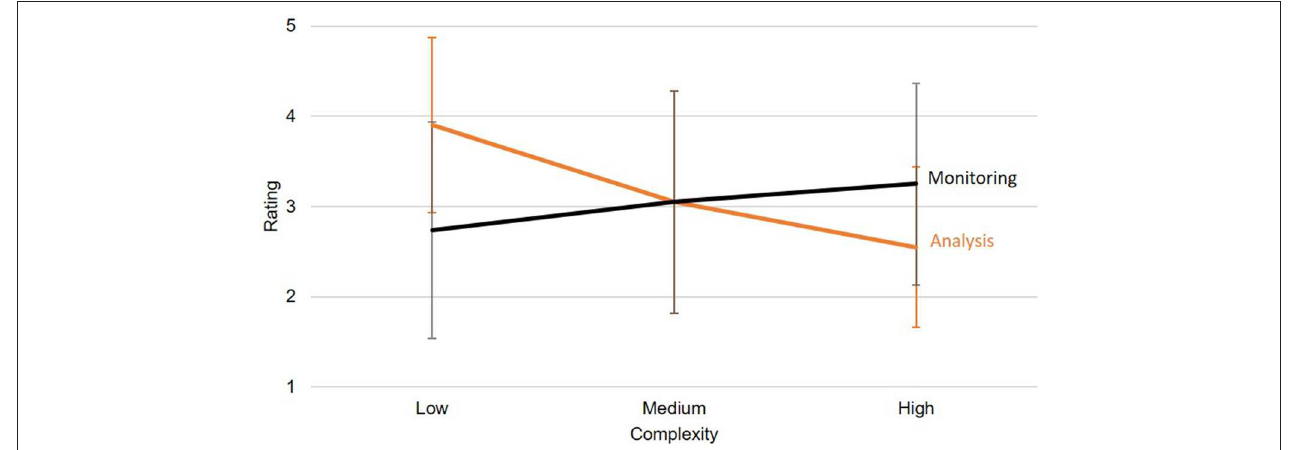
FIGURE 8 | The ANOVA showed a significant interaction effect between the task and the complexity regarding the rating. Error bars show standard